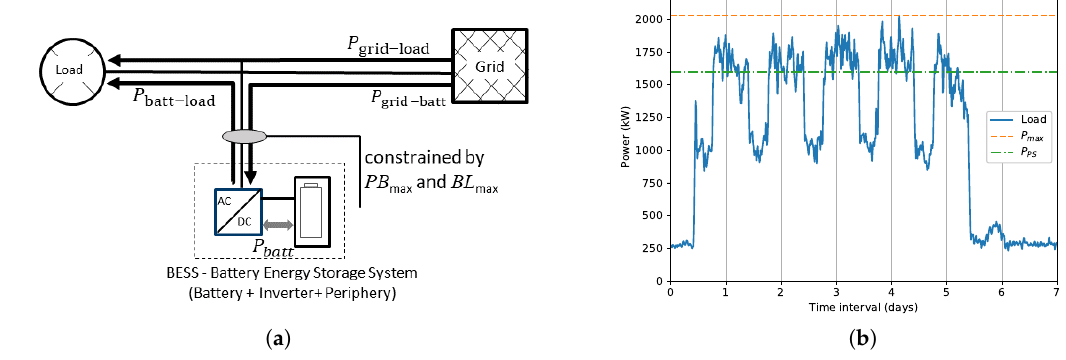
Figure 1. System configuration showing all ( a ) considered power flows and ( b ) customer load curve with price